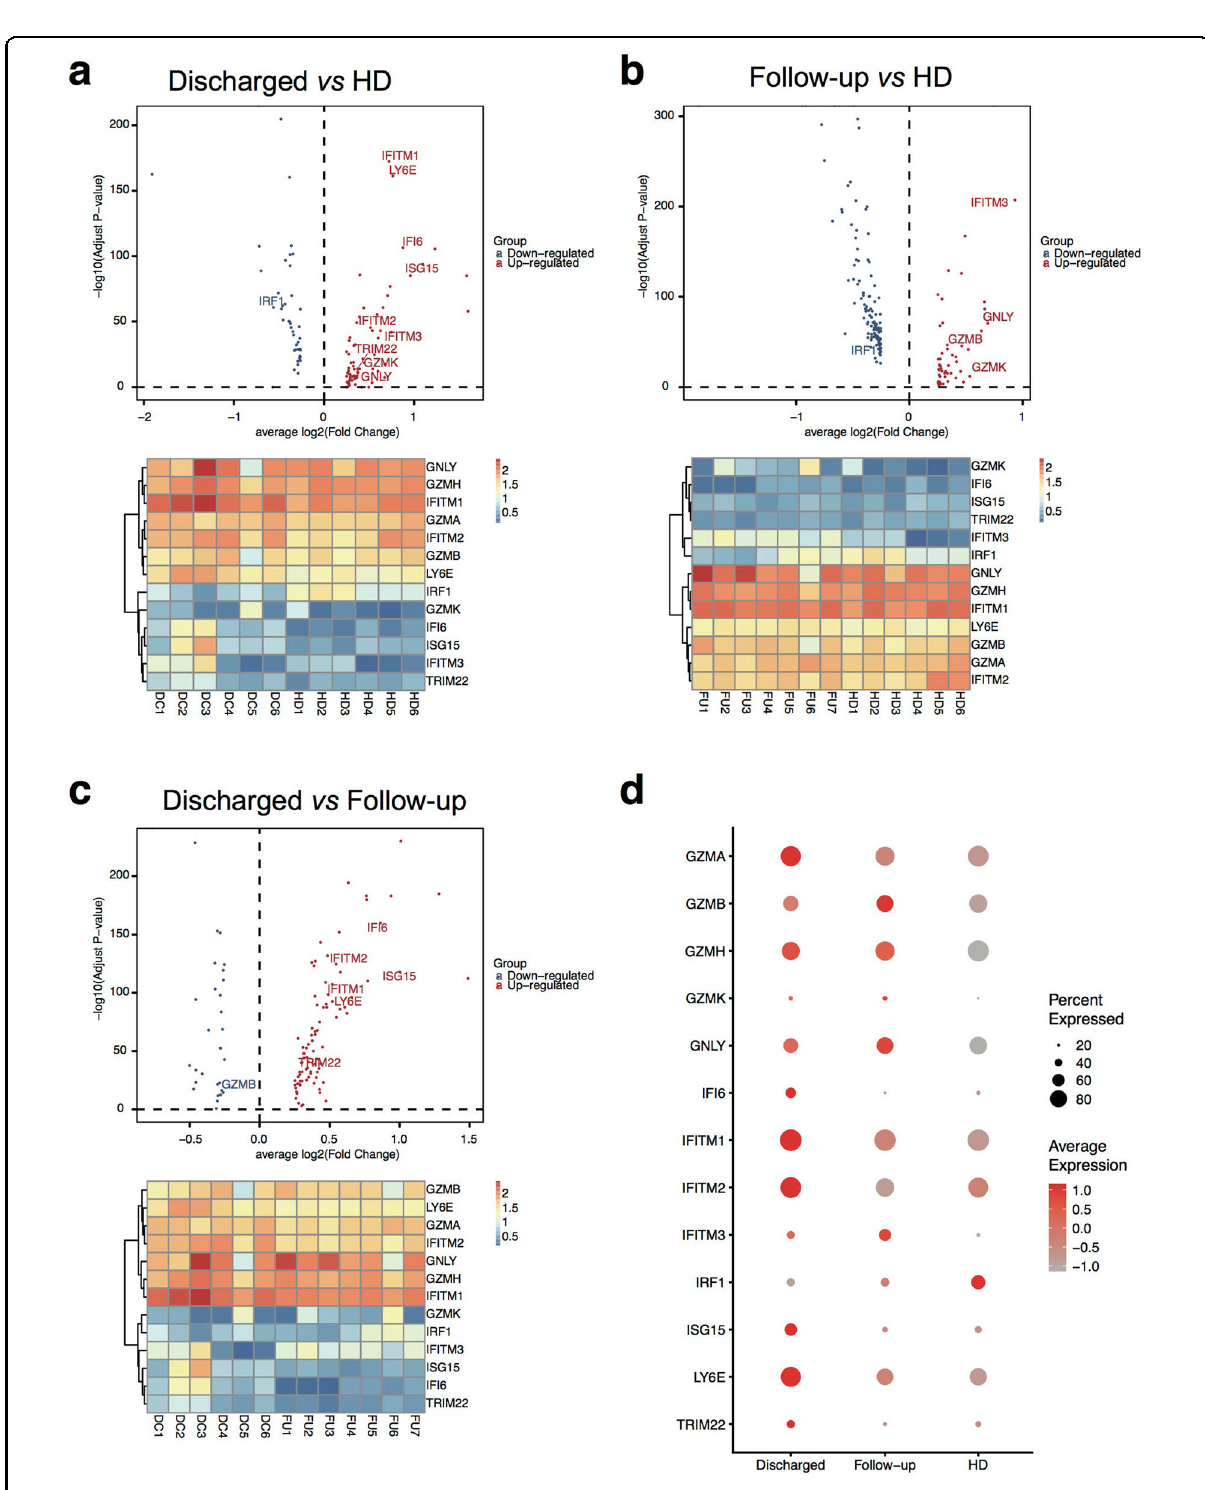
Fig. 4 Deferentially expressed immune-related genes of CD8 + subset from top 20 TCR clonotypes paired scRNA-seq data. The volcano plot of signi fi cantly changed genes and the heatmap of selected granzyme- and interferon-related genes of CD3E + CD8A + CD4 − clusters in top 20 TCR clonotypes from Discharged group vs . HD group ( n = 6 per group) ( a ), from Follow-up group vs . HD group ( n = 7 in Follow-up group, n = 6 in HD group) ( b ), and from Discharged group vs . Follow-up group ( c ). d The bubble plot of selected granzyme- and interferon-related genes ’ expression level in Discharged, Follow-up, and HD groups ( n = 6 in Discharged and HD group, n = 7 in Follow-up group) of CD3E + CD8A + CD4 − clusters in top 20 TCR clonotypes. DC, Discharged group; FU, Follow-up group; HD, Healthy Donor